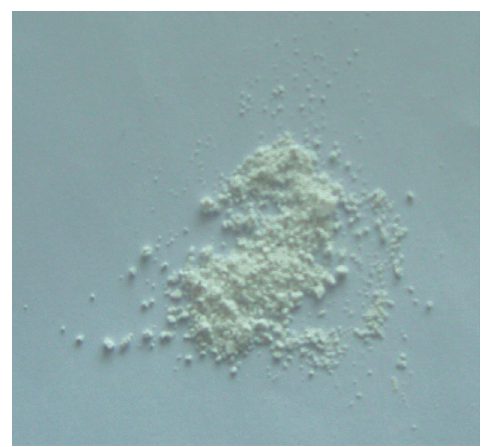
Fig. 7: The collected